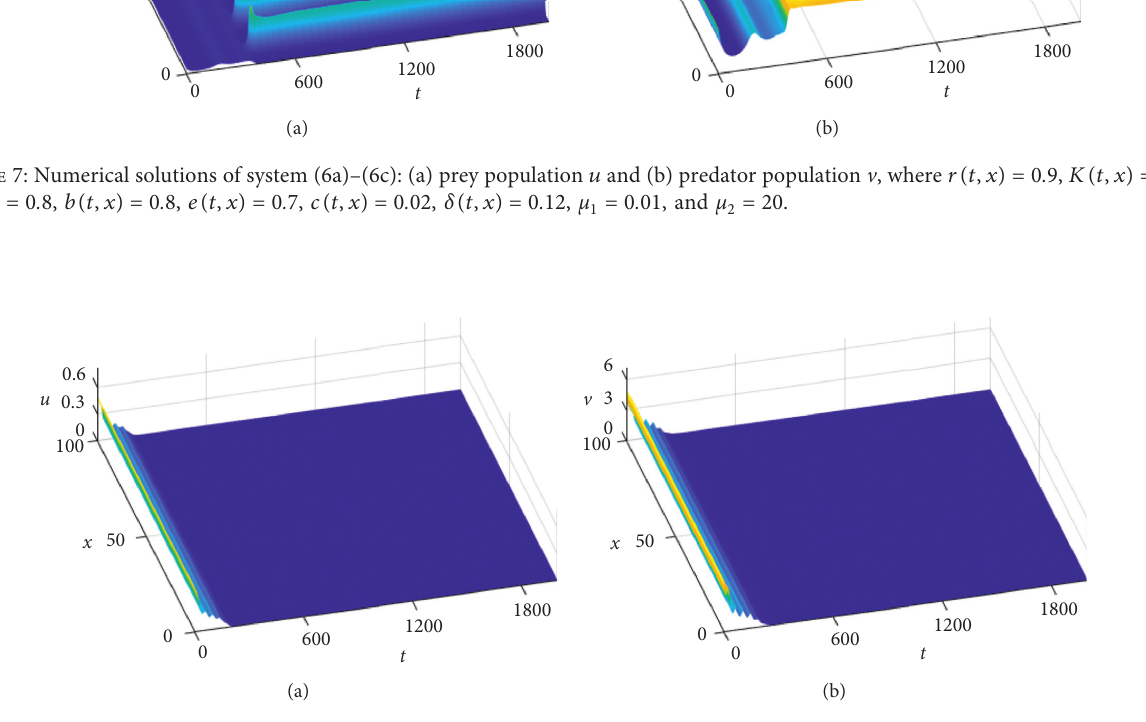
Figure 8: Numerical solutions of system (6a)–(6c): (a) prey population u and (b) predator population v , where r ( t, x ) � 0 . 9 + 0 . 001 sin ( 5 ∗ π ∗ t /100 ) , K ( t,x ) � 10 + 0 . 5sin ( 5 ∗ π ∗ t /100 ) , a ( t, x ) � 0 . 8 + 0 . 005 sin ( 5 ∗ π ∗ t /100 ) , b ( t,x ) � 0 . 8 + 0 . 005 sin ( 5